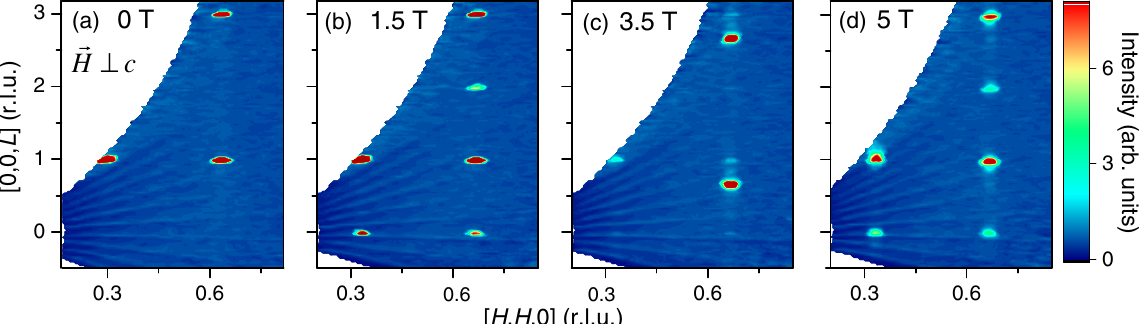
FIG. 15. (a) – (d) Representative plots of the ( H , H , L ) reciprocal plane obtained at T ¼ 1 . 7 K for magnetic fields applied along the ¯1 [1, , 0] direction. The μ 0 H ¼ 3 . 5 T data show a shift along the L direction of magnetic peaks to a slightly incommensurate position δ L ¼ 0 . 654 . At 5 T, the magnetic phase recovers its original commensurate state with the wave vector k ¼ ð 1